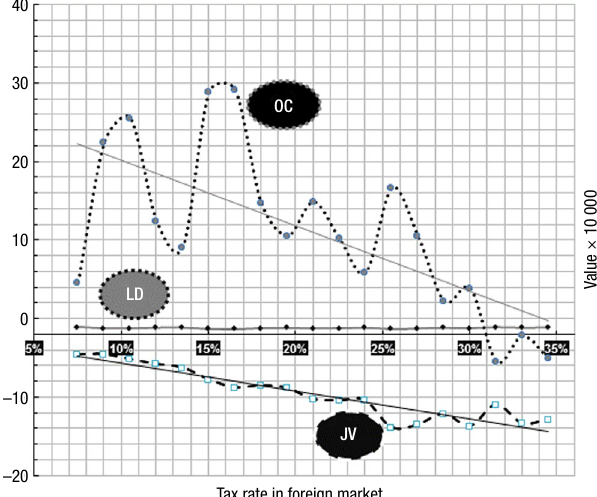
Fig. 3. Simulation of different options for entering in a FM, considering different tax